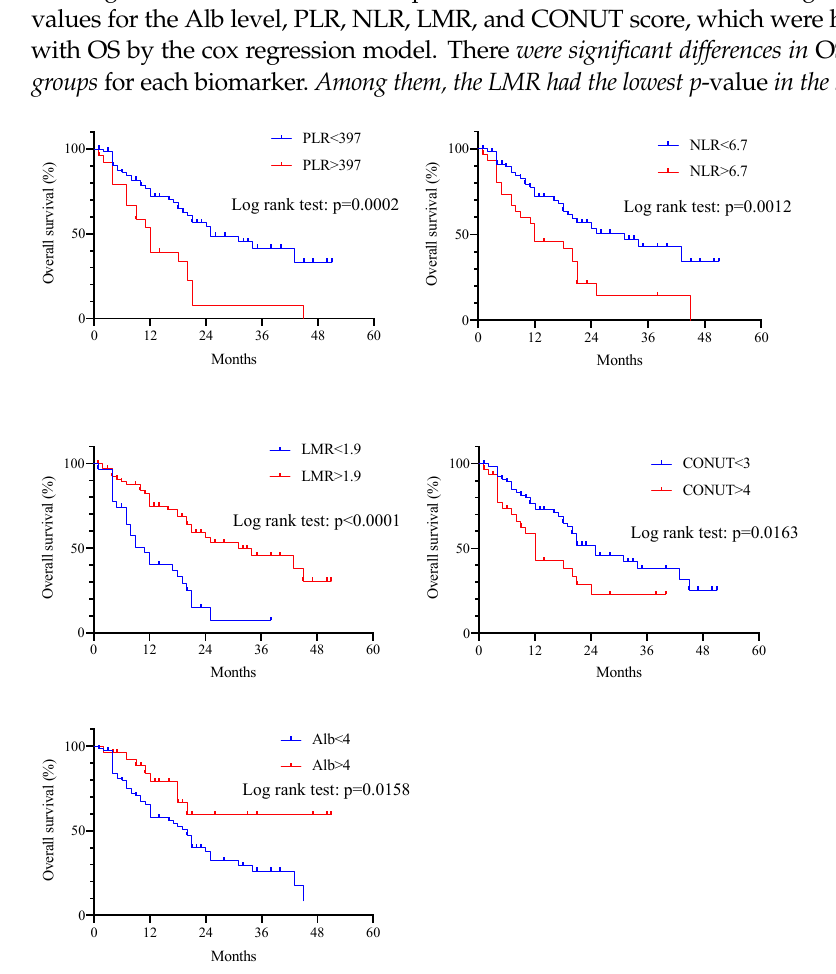
Figure 2. Kaplan–Meier curves for correlation between overall survival and PLR, NLR, LMR, CONUT score, and Alb level according to cutoff values. Significant differences in overall survival were observed between the two groups for each biomarker.